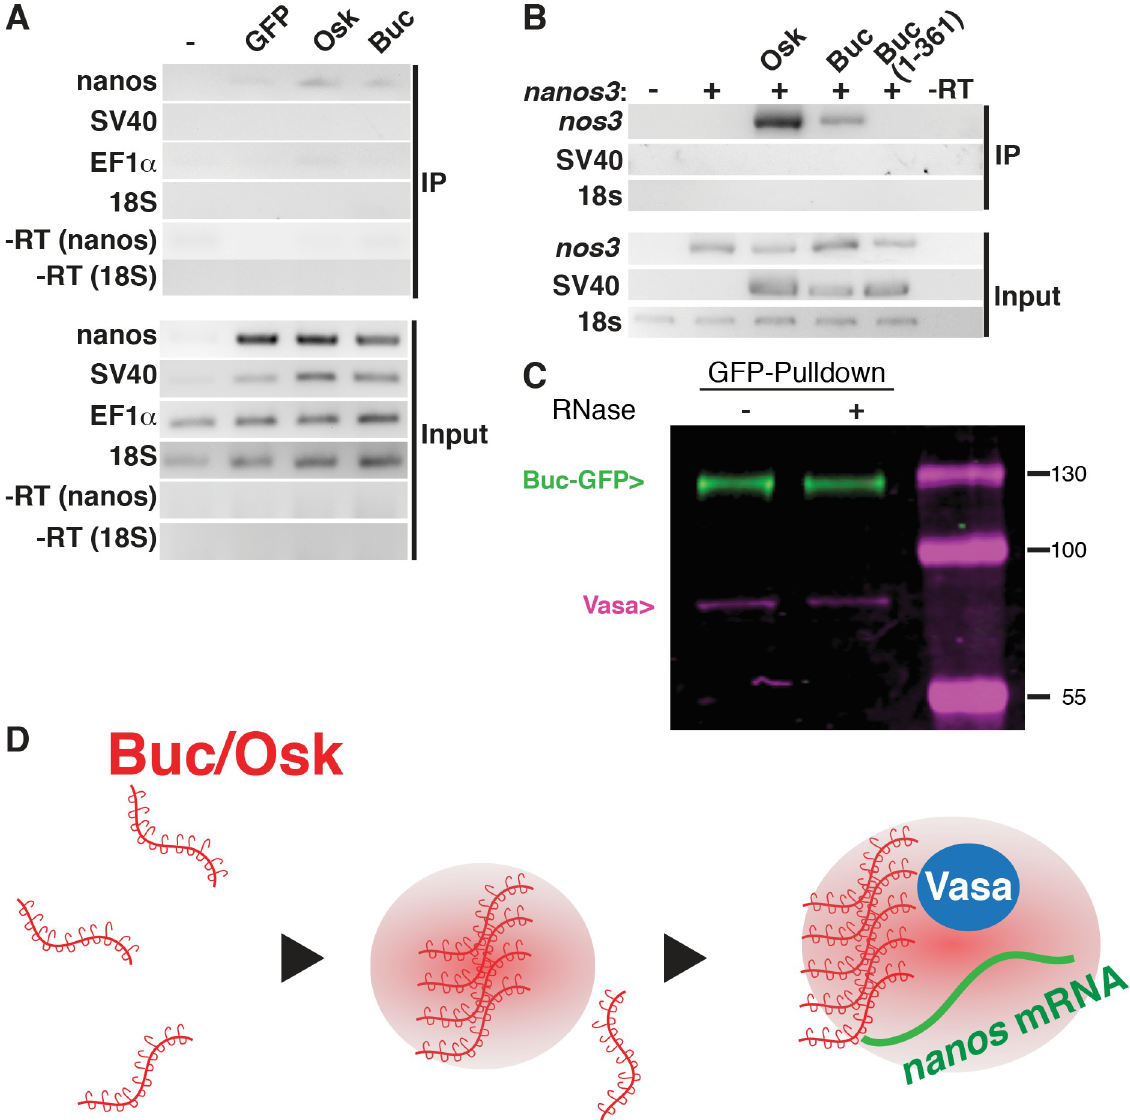
Fig 8. Buc interacts with RNA. (A) RT-PCR of zebrafish nanos3 , SV40, human EF1 α and human 18S rRNA after GFP-pulldown (IP) of HEK293 cells either untransfected (-) or transfected with GFP, Osk-GFP or Buc-GFP together with Cherry-nos-3’UTR and Cherry-SV40- 3’UTR. RNA levels before GFP-pulldown (Input) show endogenous 18S rRNA and EF1 α mRNA, and transfected Cherry-nos-3’UTR and Cherry-SV40-3’UTR. nos3-3’UTR is detected in Osk and Buc samples after GFP-pulldown (IP).–RT: RNA without reverse transcriptase control. (B) Buc(1–361)-GFP does not pulldown nos3-3'UTR . Cherry-nos-3’UTR (+), alone or cotransfected with Osk-GFP, Buc-GFP or Buc (1–361)-GFP including SV40-3’-UTR. (C) RNase treatment (+) prior to GFP pulldown of in vitro translated protein does not disrupt Buc- Vasa interaction. (D) Model for germ plasm formation. Single Buc or Osk molecules (red) aggregate through weak interactions of their intrinsically disordered regions (hooks and loops), until a threshold concentration is reached. This leads to a liquid-liquid phase separation (red haze) to form hydrogel-like germ plasm. The aggregate then recruits Vasa protein (blue) and nanos mRNA (green).